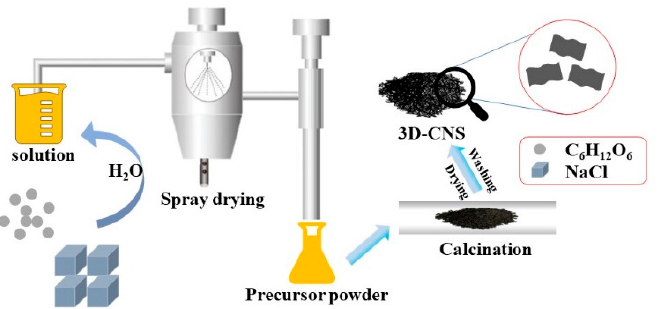
Figure 1. Schematic illustration of the synthesis process of the 3D-CNS precursor powder by spray